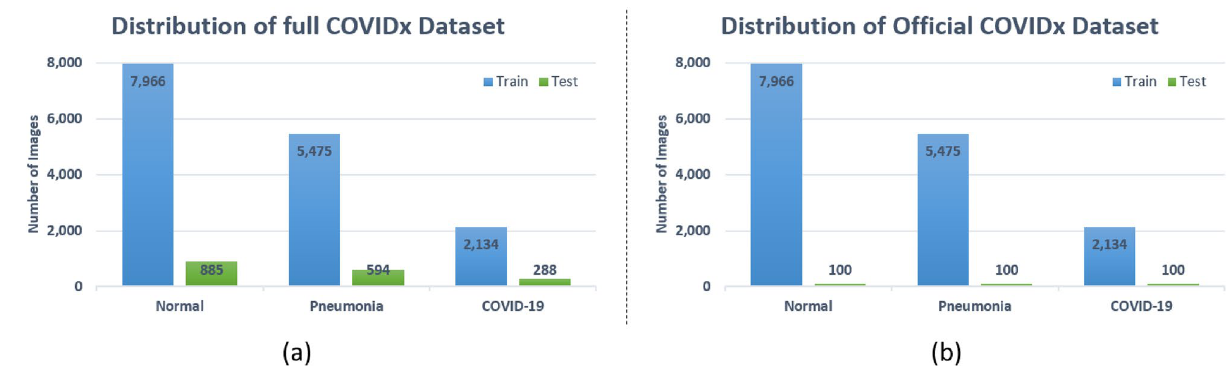
Figure 4. Class distribution of COVIDx dataset, where normal means no infection. Right bar depicts number of test CXRs, left bar depicts number of training